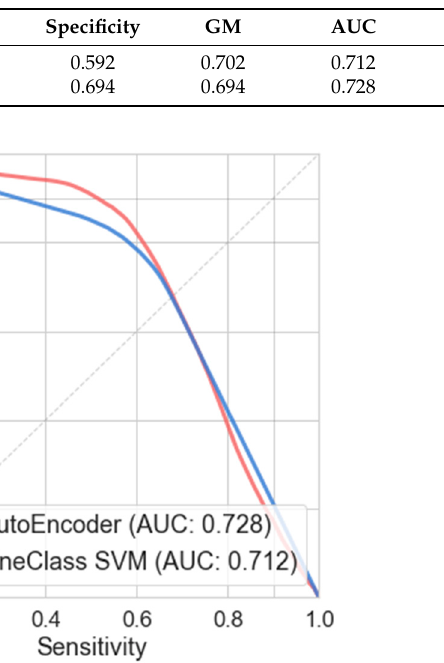
Table 6. LOSO evaluation results of the supervised classification models with a data representation of 64-bin FFT and overlap 75%.